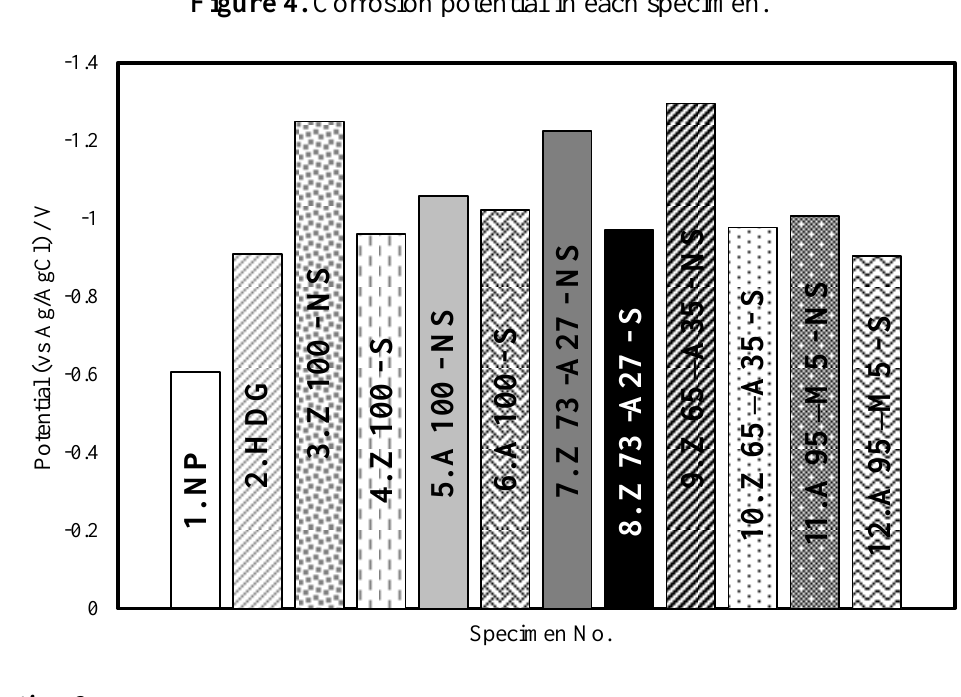
Figure 4. Corrosion potential in each